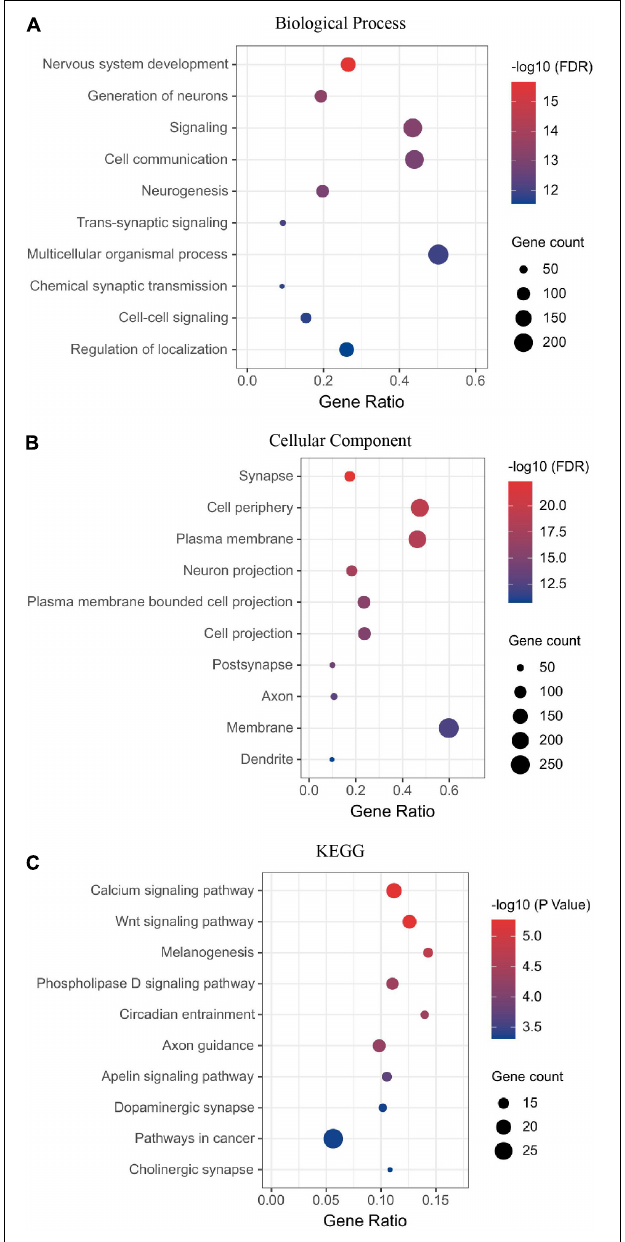
FIGURE 2 | Visual deprivation leads to the regulation of neural developmental factors in the primate dLGN, as shown in the enrichment analysis of DEGs (A) Biological process. (B) Cellular component. (C) KEGG analysis of DEGs.